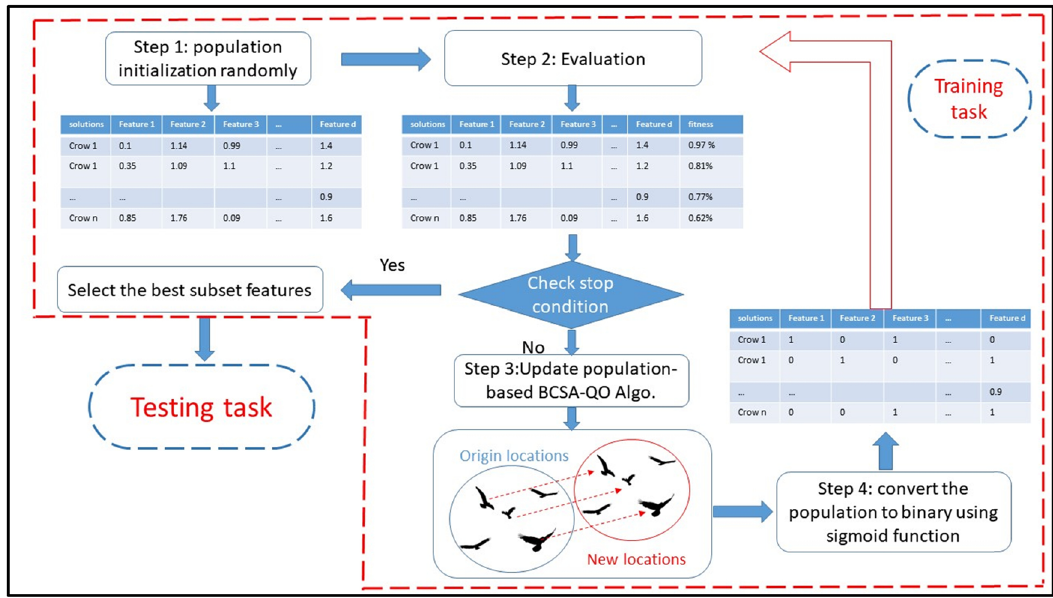
Figure 2: Flowchart of the proposed method ( BCSA - QO )